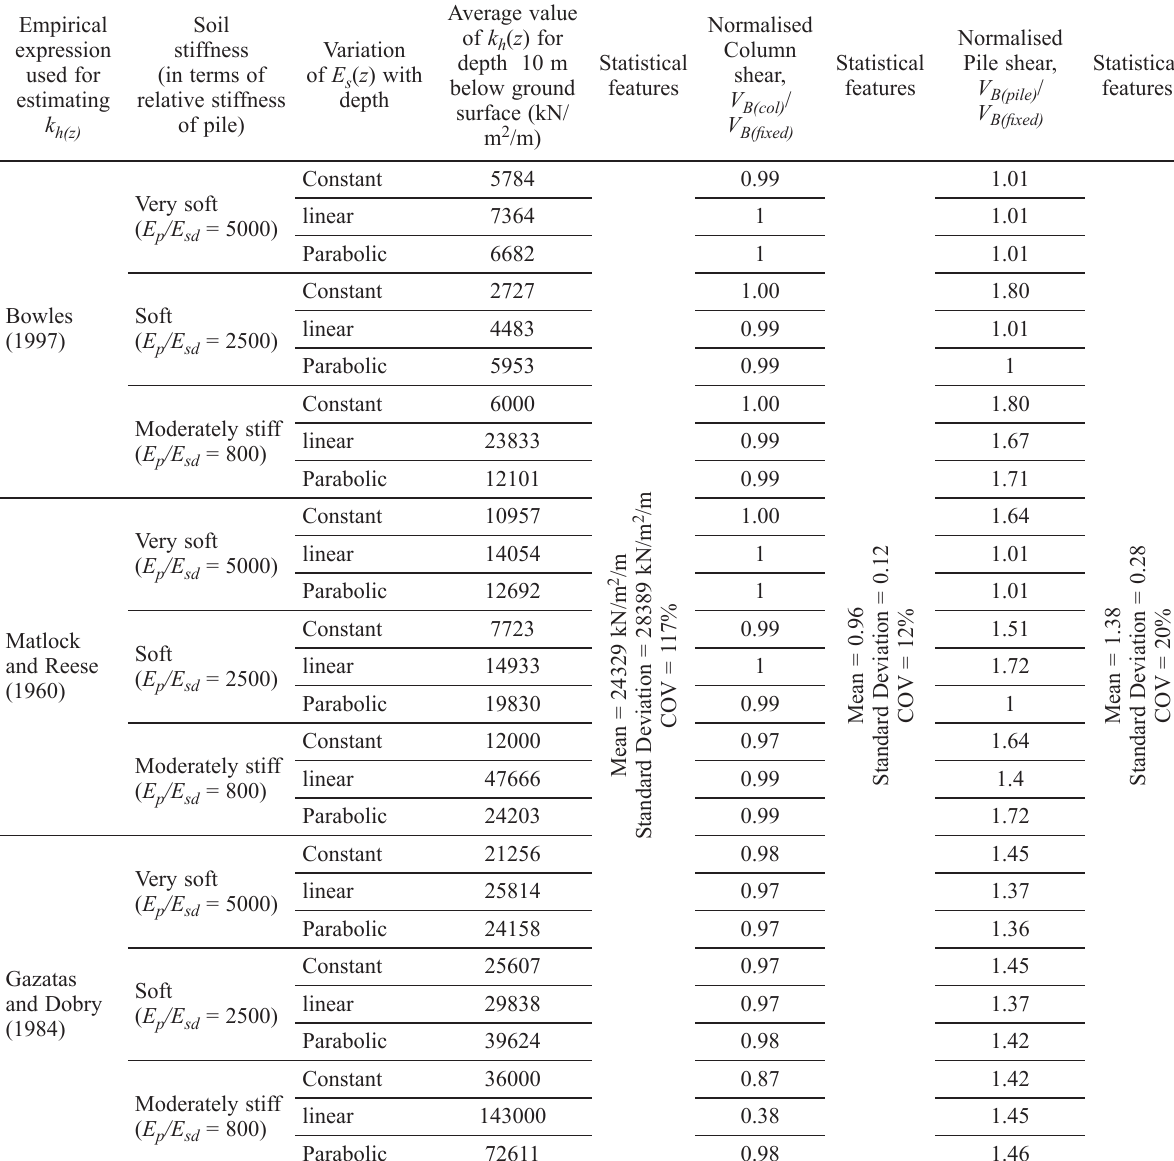
Table 10. Results for statistical analysis determined from 27 input values of of k h ( z ) , V B(col) / V B(fixed) and V B(pile) / V B(fixed) Empirical